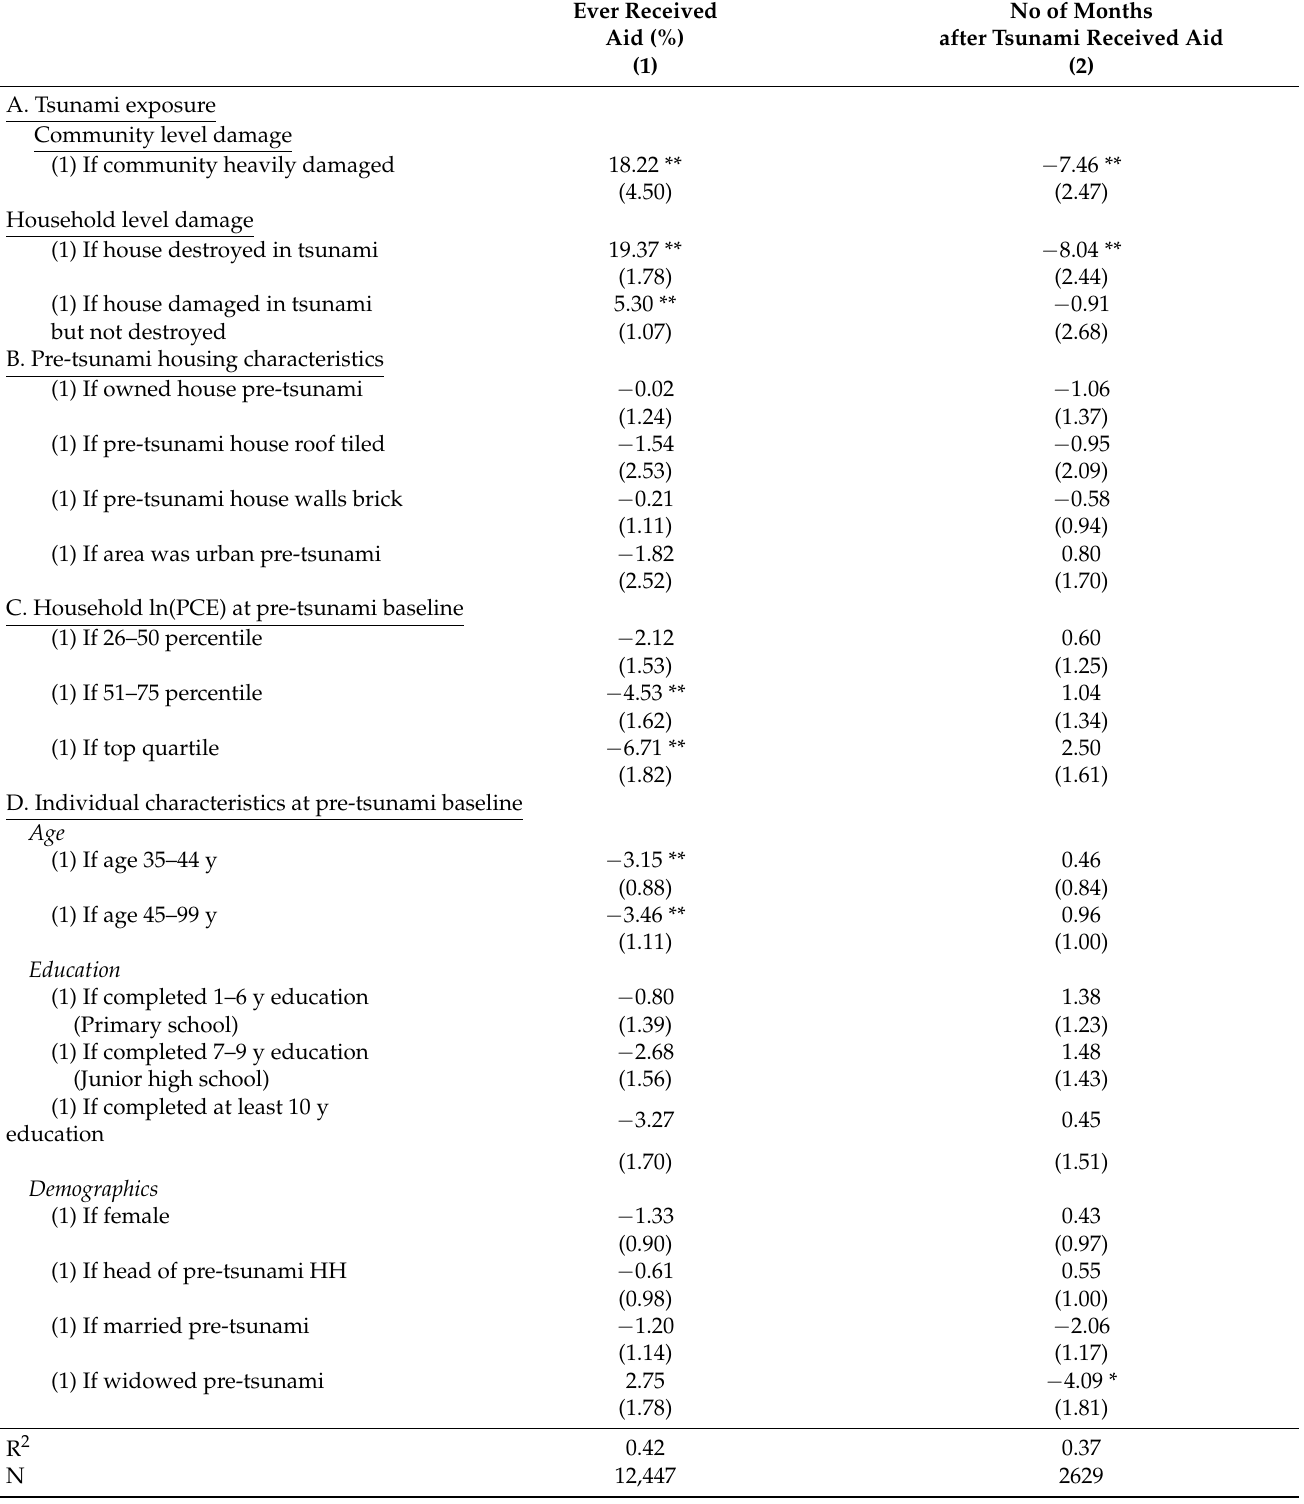
Table 5. Predictors of receipt of housing aid and timing of receipt of